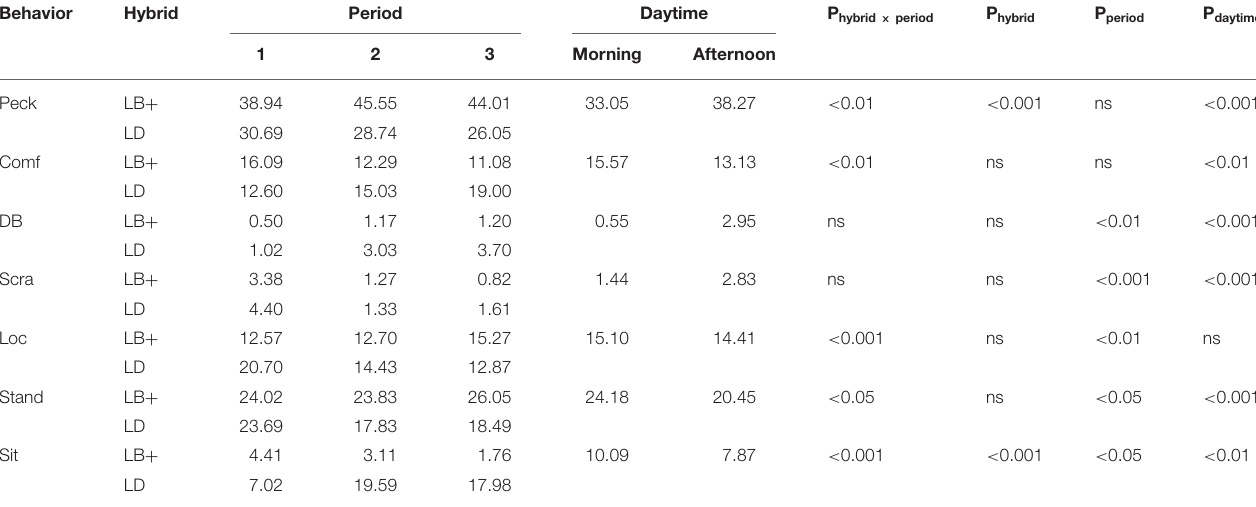
TABLE 4 | Proportions of conventional layer (LB + ) and dual-purpose (LD) hybrids performing distinct behaviors at three times during the laying period (1: 25th − 30th, 2: 43rd − 48th, 3: 64th − 69th week of life) and the day (morning/afternoon). Behavior Hybrid Period Daytime P hybrid ×